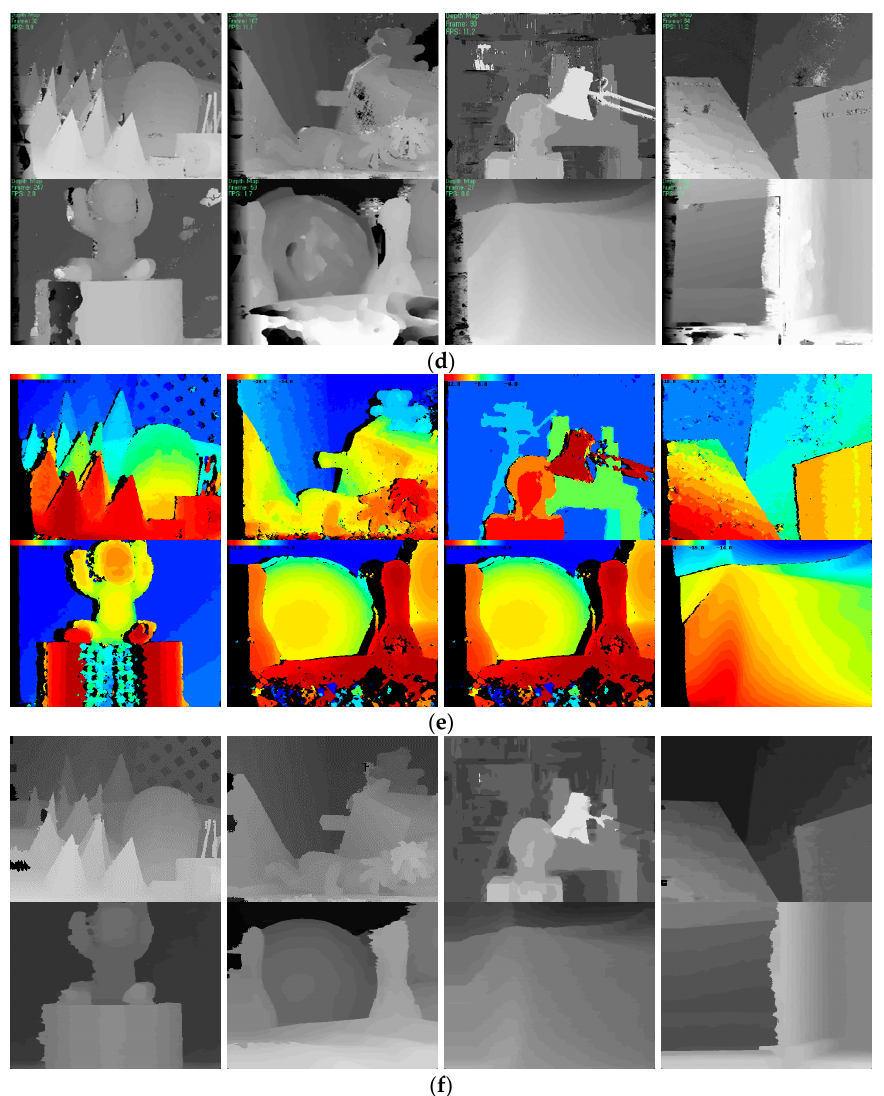
Figure 7. ( a ) Reference images (Middlebury) and ( b ) ground truth disparity maps; Disparity maps by ( c ) dual-cross-bilateral (DCB) grid [23]; ( d ) adaptive weight [21]; ( e ) MGM [24]; and ( f ) proposed